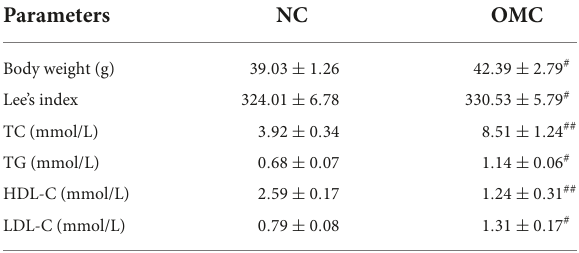
TABLE 1 Body weight, Lee’s index, and serum biochemical markers on the 30th day.